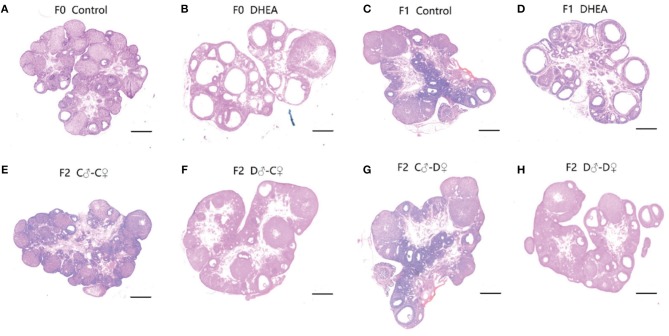
Ovarian morphology of control (A), DHEA (B), F1 control (C), F1 DHEA (D), F2 C♂-C♀ (E), F2 D♂-C♀ (F), F2 C♂-D♀ (G), and F2 D♂-D♀ (H) ovaries in the same magnification (magnification ×0.8; scale bars: 200 μm). (A), (C), and (E) Ovaries from a normal cycling control rat of F0, F1, and F2, showing CL and follicles at different stages. (B) Ovary from a DHEA-exposed rat, showing many cystic follicles similar to (D) (F1 DHEA). (F) Ovary from an F2 D♂-C♀ rat. (G) Ovary from an F2 C♂-D♀ rat. (H) Ovary from an F2 D♂-D♀ rat, showing increased primary follicles and primordial follicles.